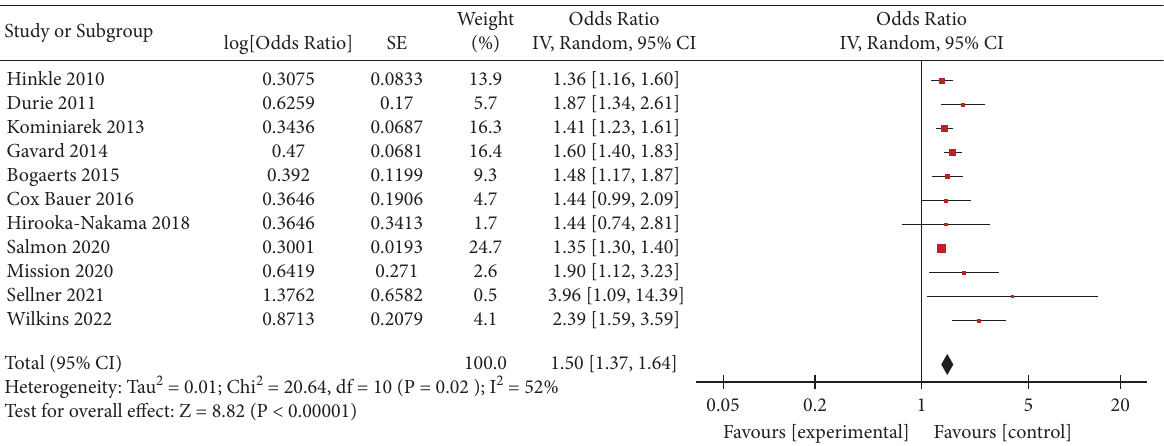
Figure 3: Forest plot of the association between weight loss in obese women and